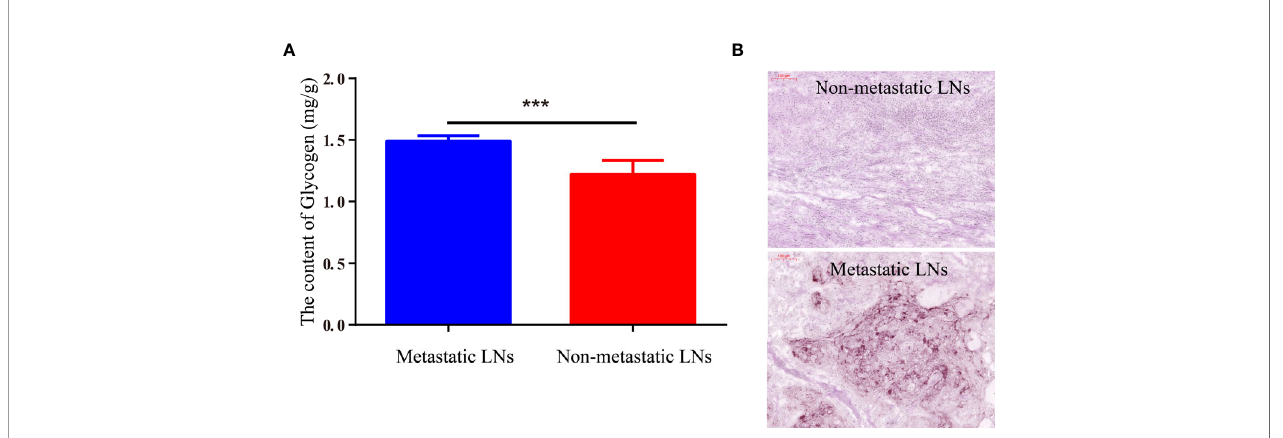
FIGURE 6 | The content of glycogen in metastatic LNs and nonmetastatic LNs. (A) The quantitative content of glycogen detected by Liver/Muscle Glycogen Assay Kit. (B) PAS staining image of LNs with/without metastasis (***p